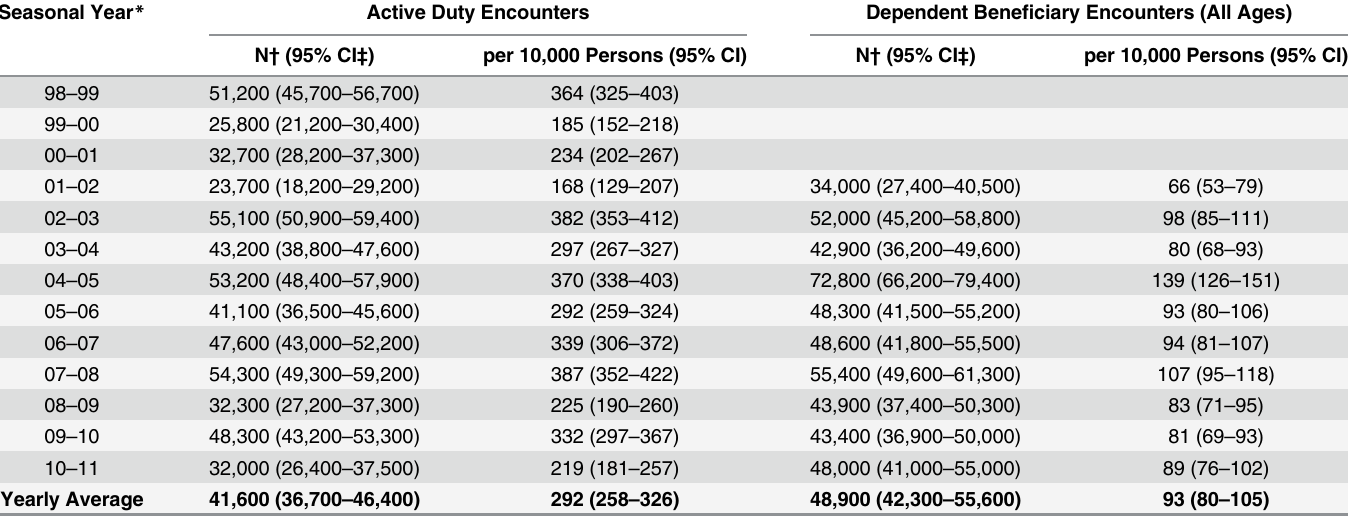
Table 4. Norovirus-attributable encounters by season and